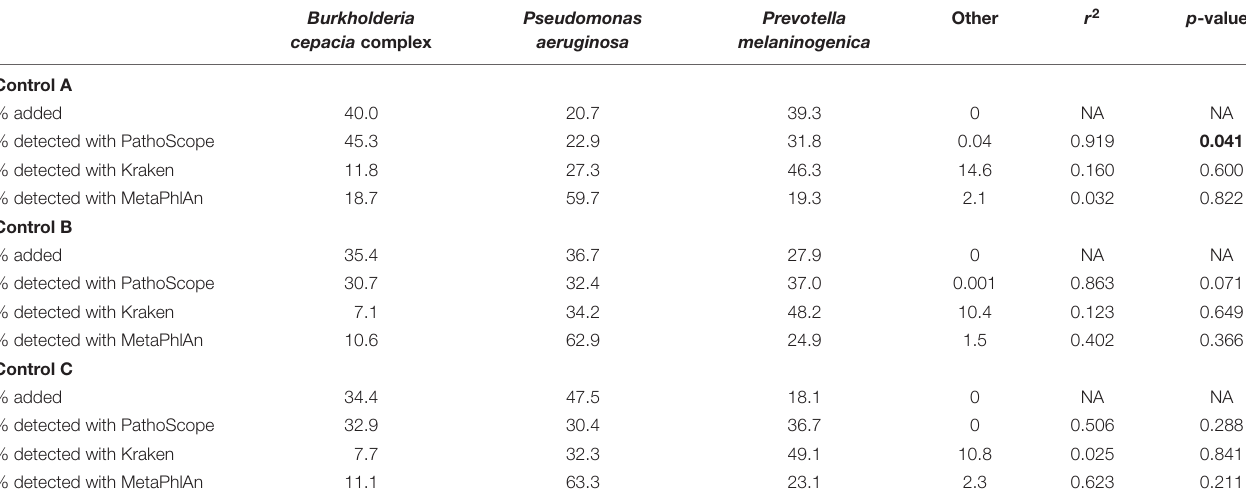
TABLE 2 | Expected and obtained proportions of artificial